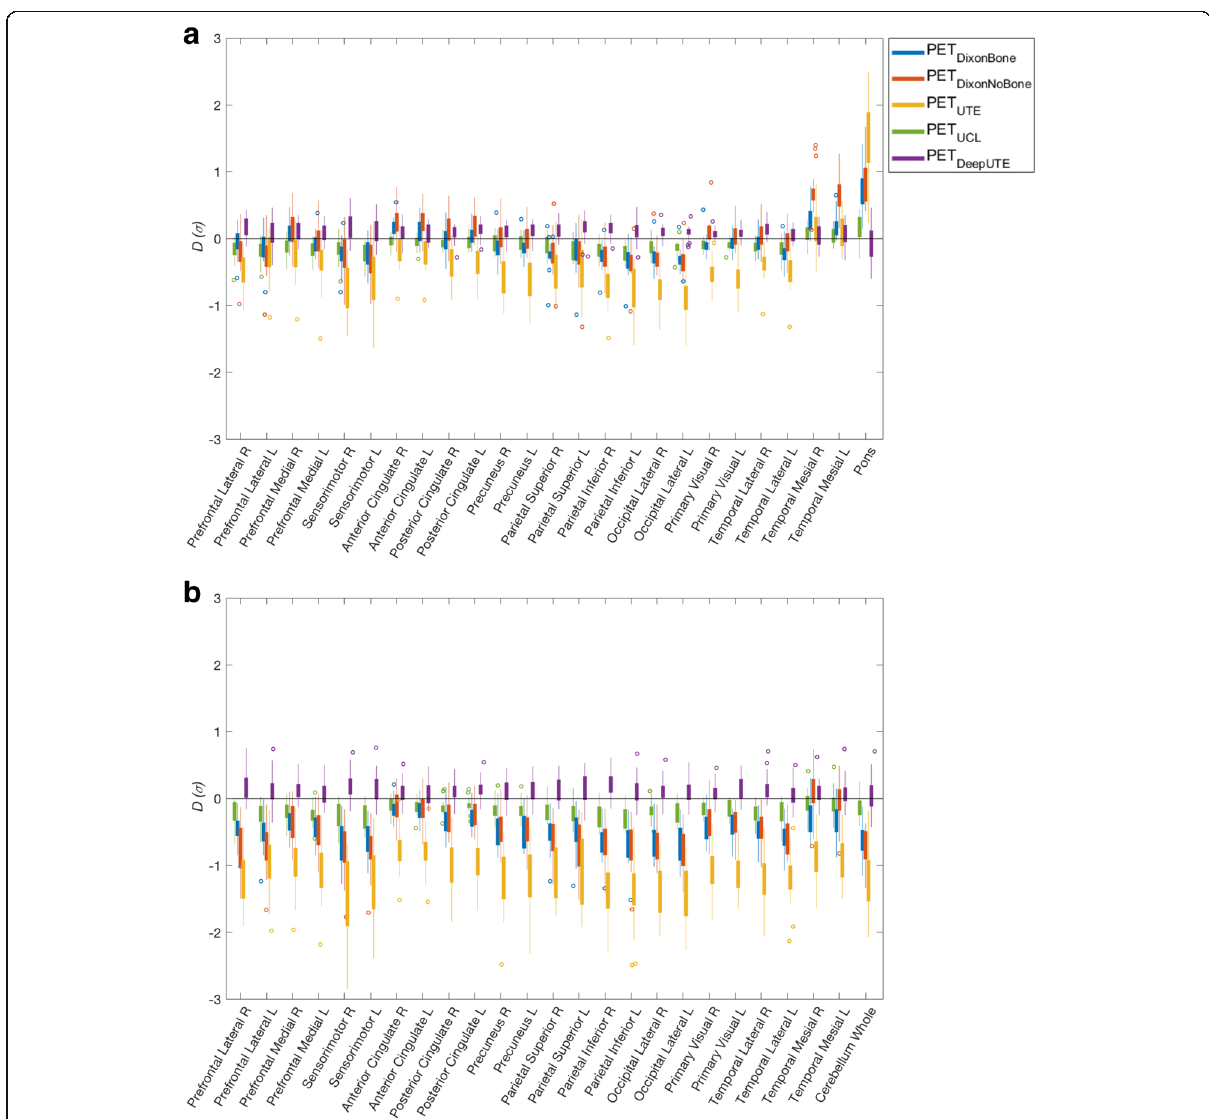
Fig. 3 Difference in z-score between PET MRAC (PET DixonBone , PET DixonNoBone , PET UTE , PET UCL , PET DeepUTE ) and PET CTAC , for different brain regions, with a cerebellum and b pons as reference region. Top and bottom edges of the boxes indicate 25th and 75th percentiles, while the whiskers extend to the most extreme data points, except for outliers that are marked as